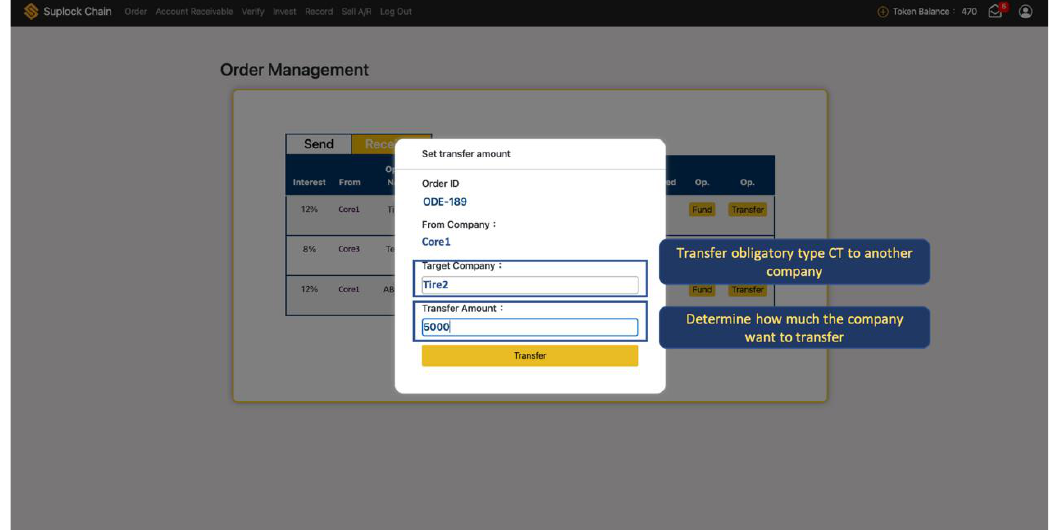
Figure A13 is the transfer operation. The wallet of the Tier 2 company is 0xcc